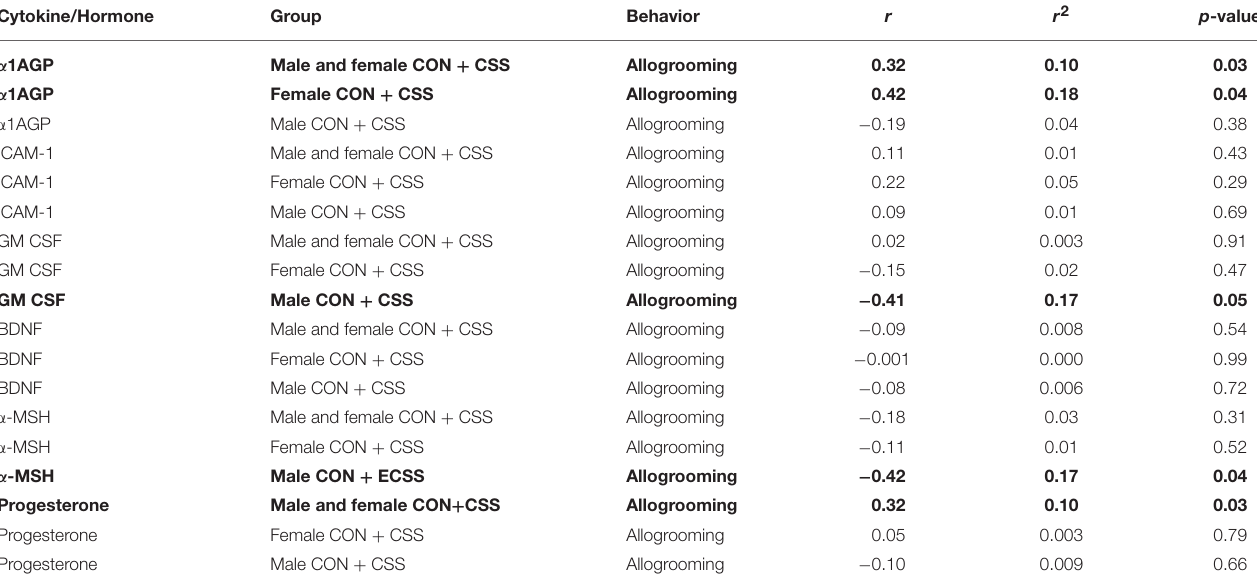
TABLE 1 | Pearson Correlation coefficient and p -values for immune targets and hormones and allogrooming behavior during a social interaction test for factors significantly affected by chronic social stress in adult male and female F2 offspring of control (CON) and chronic social stress (CSS) dams. Cytokine/Hormone Group Behavior r r 2 p -value Male and female CON + CSS Allogrooming Female CON +